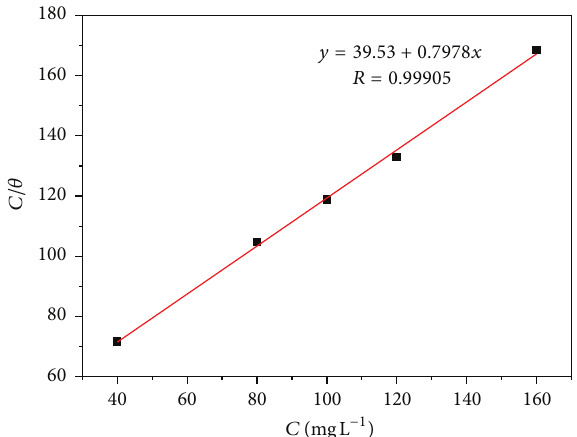
Figure 8: Langmuir adsorption isotherm of EAPP on carbon steel in 0.5 M HCl at 300 K from weight loss measurements.